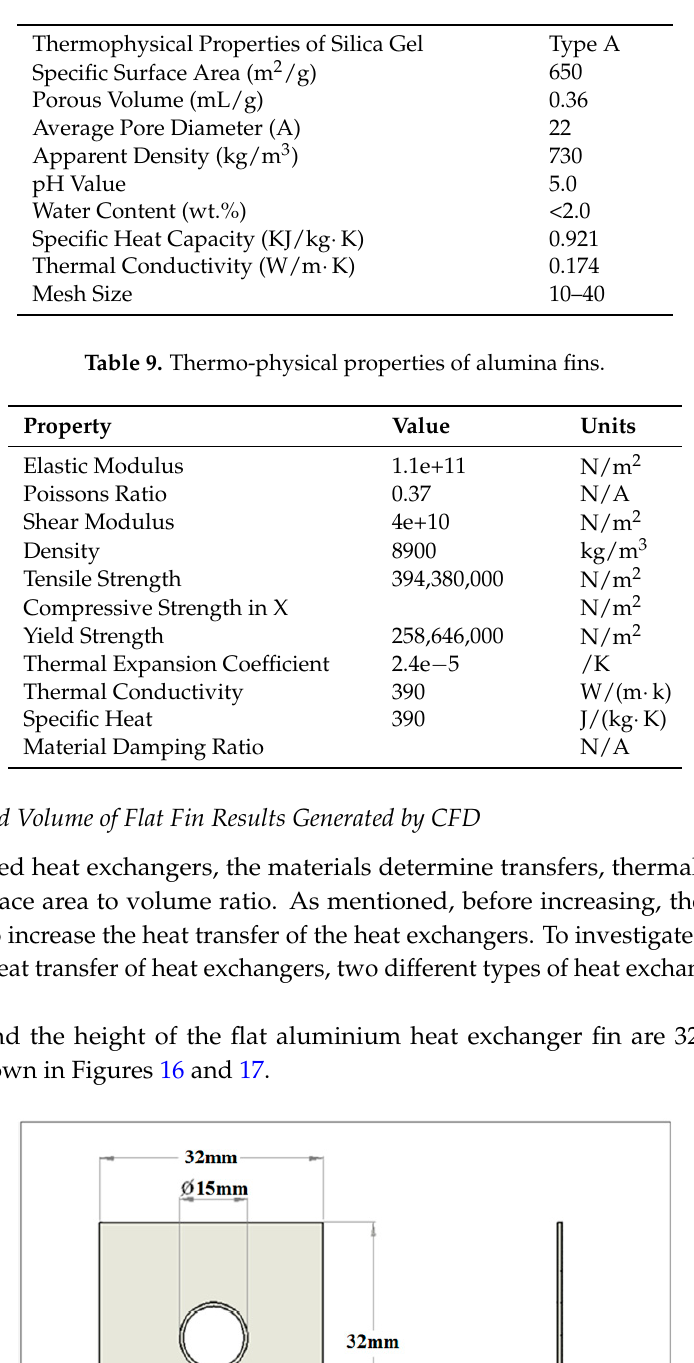
Table 8. Thermo-physical properties of silica gel.